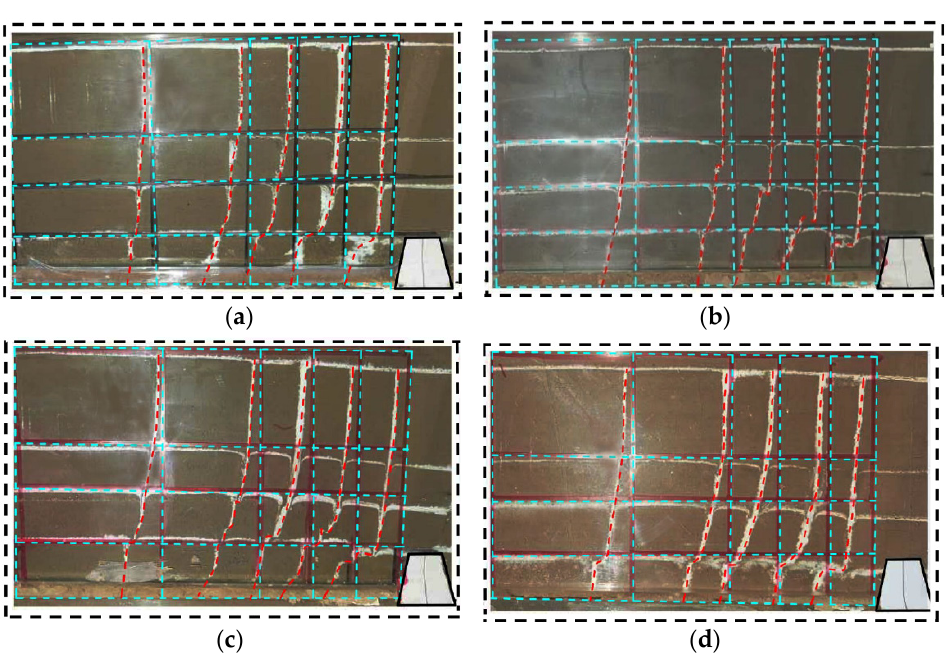
Figure 15. Final deformation of 8 b screw shear plate. ( a ) 40 kPa, ( b ) 80 kPa, ( c ) 120 kPa, and ( d ) 160 kPa.